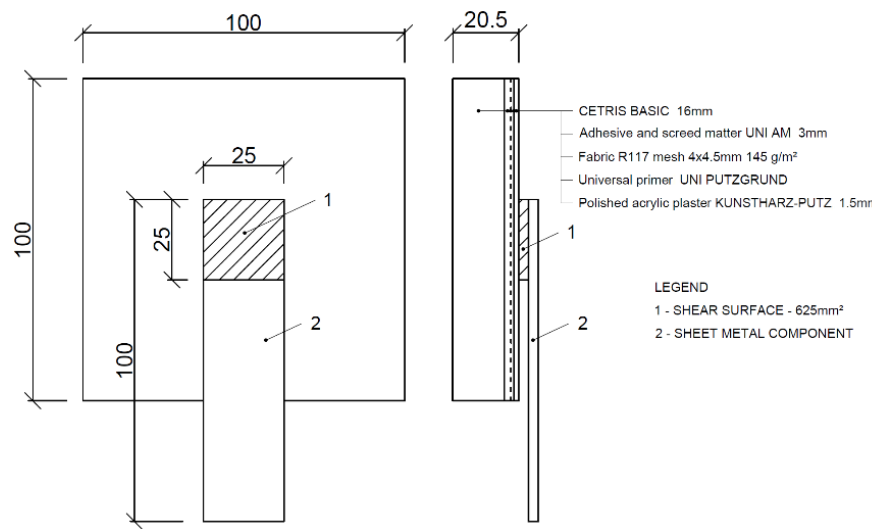
Figure 2. Test specimen for shear test.